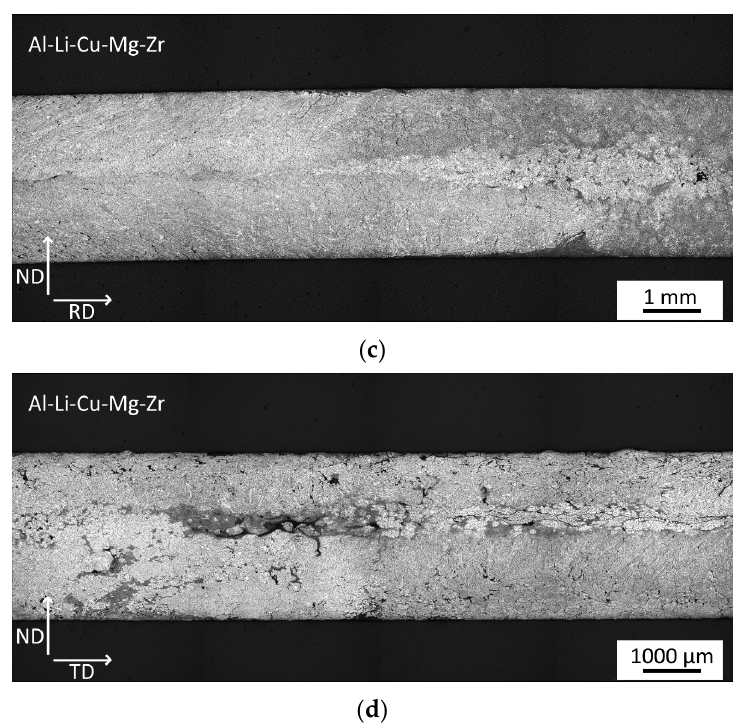
Figure 2. Microstructure on the transverse ( a , c ) and longitudinal ( b , d ) sections from Figure 1 of as-cast Al-Li-Cu-Mg-Zr-Sc ( a , b ) and Al-Li-Cu-Mg-Zr ( c , d ) alloys.